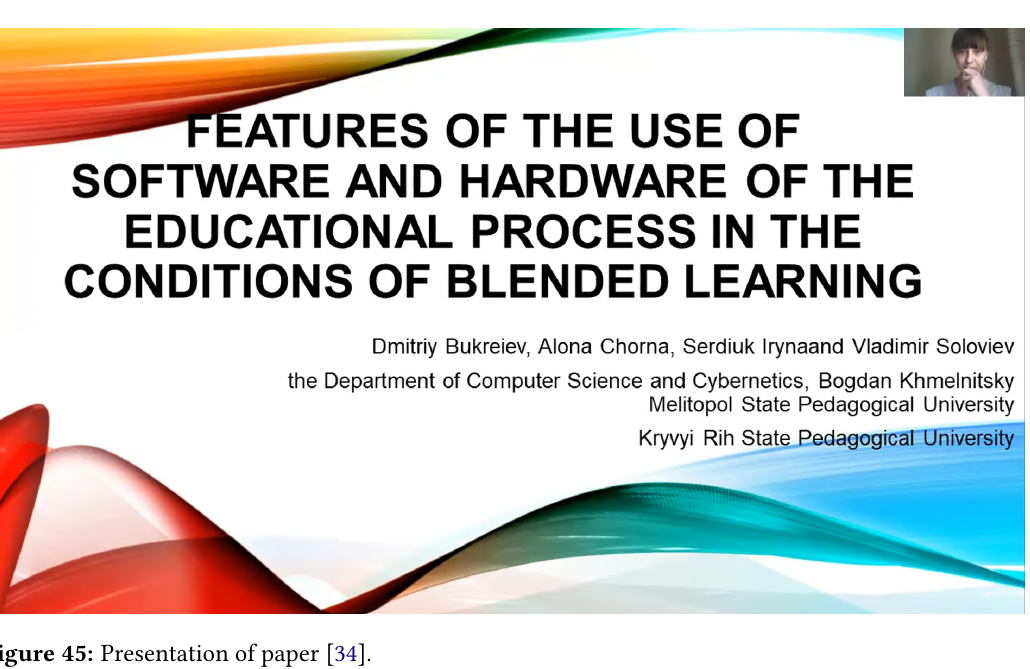
Figure 45: Presentation of paper